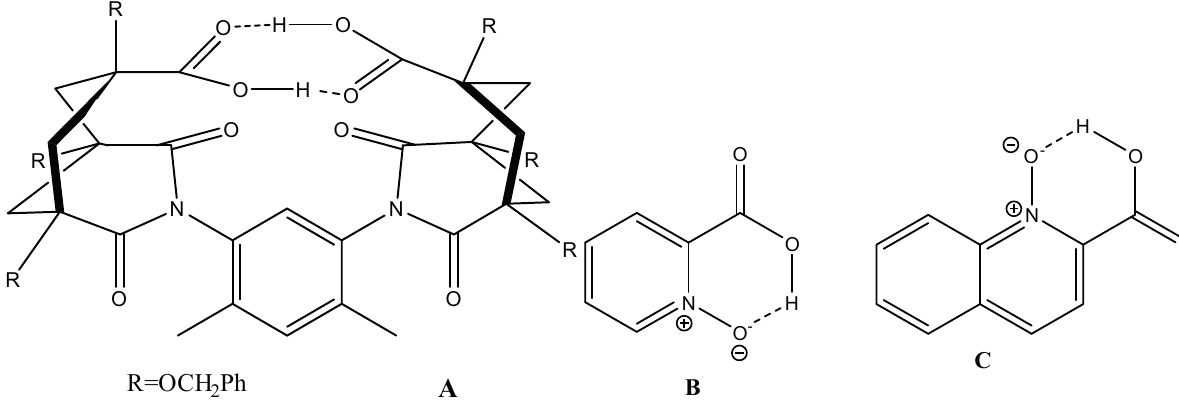
Figure 10. Plot of primary isotope effects, P Δ (OD) vs. OH chemical shifts. Acceptors atoms are O, N or S. Data taken from Refs. [40,41].